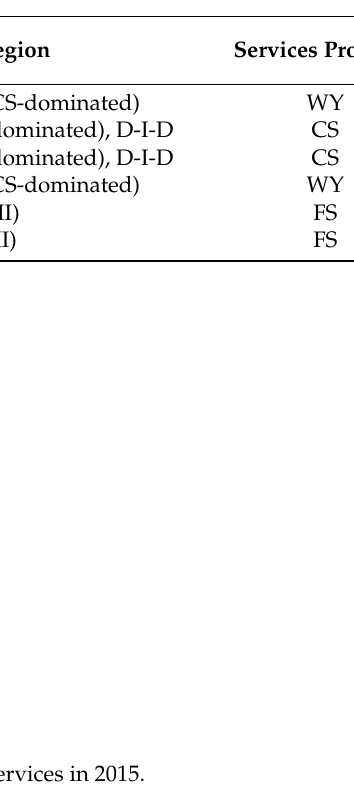
Figure 13. Spatial distribution of dominant ecosystem services of WY and CS. Table 7. Improvement priority in D-D-D in 2015.